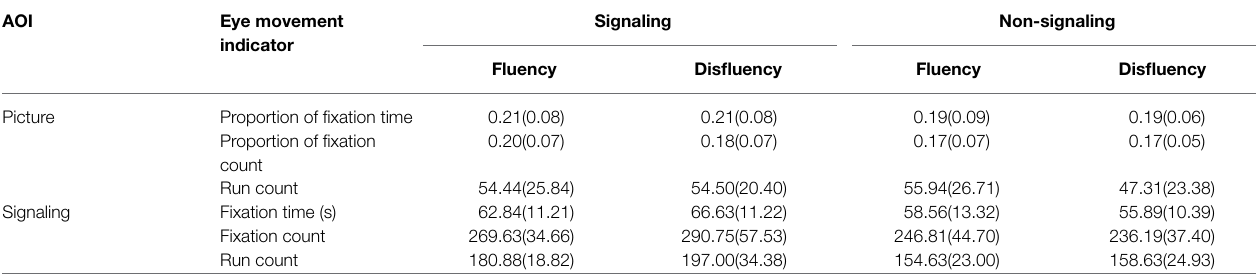
TABLE 2 | Means and SDs for eye-tracking measures. AOI Eye movement